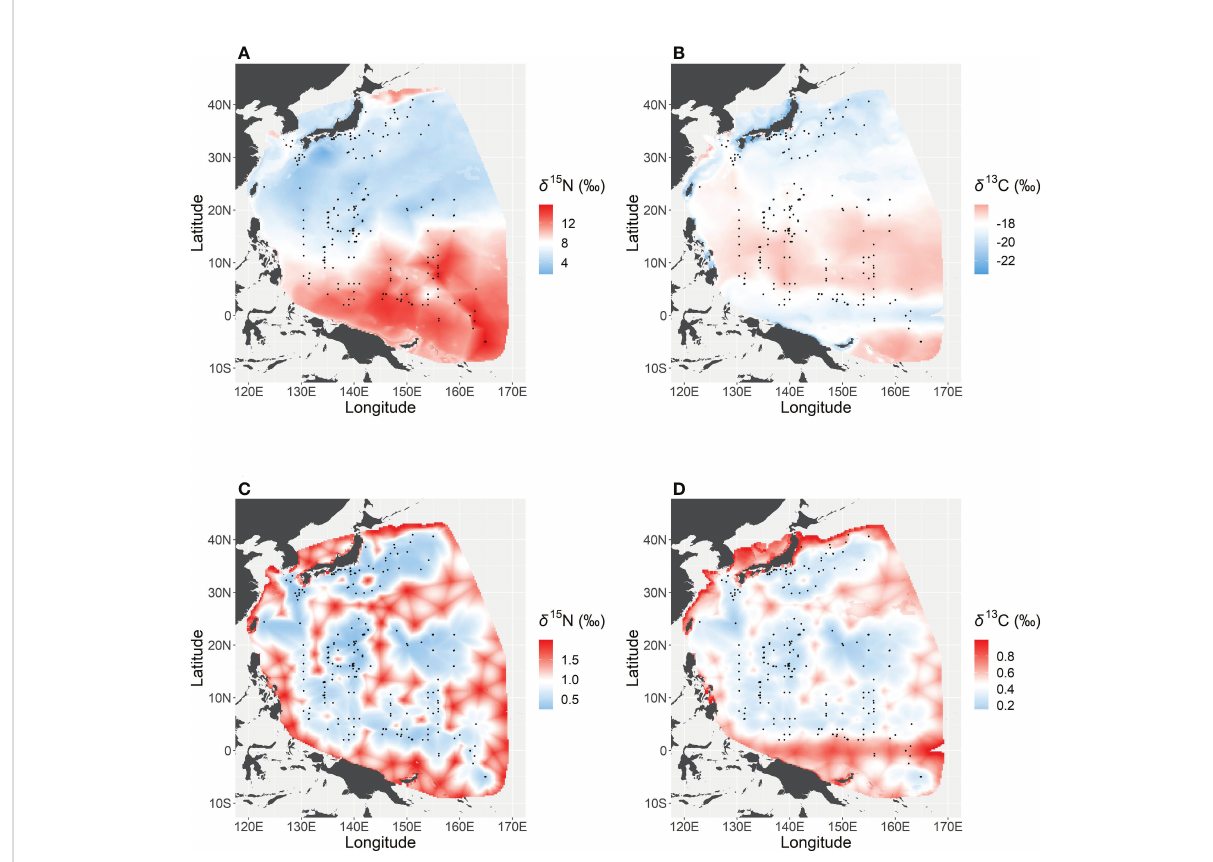
FIGURE 4 Isoscapes of nitrogen (A) and carbon (B) stable isotope ratios in the western Paci fi c, and the uncertainty (standard deviation) of predicted nitrogen (C) and carbon (D) isotope ratios estimated by simulation from the best- fi t models ( n =